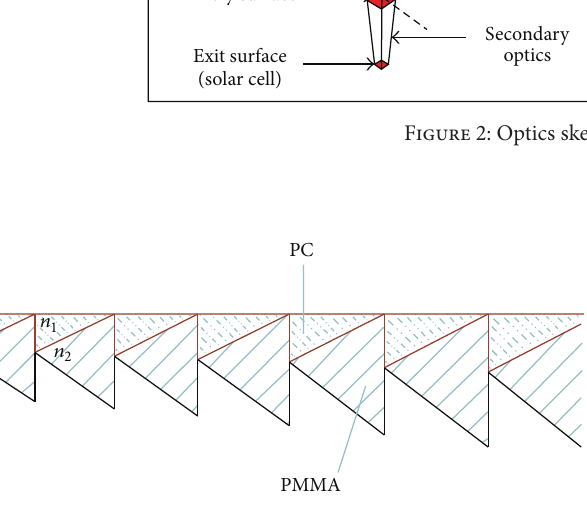
Figure 3: Section of the achromatic Fresnel lens.